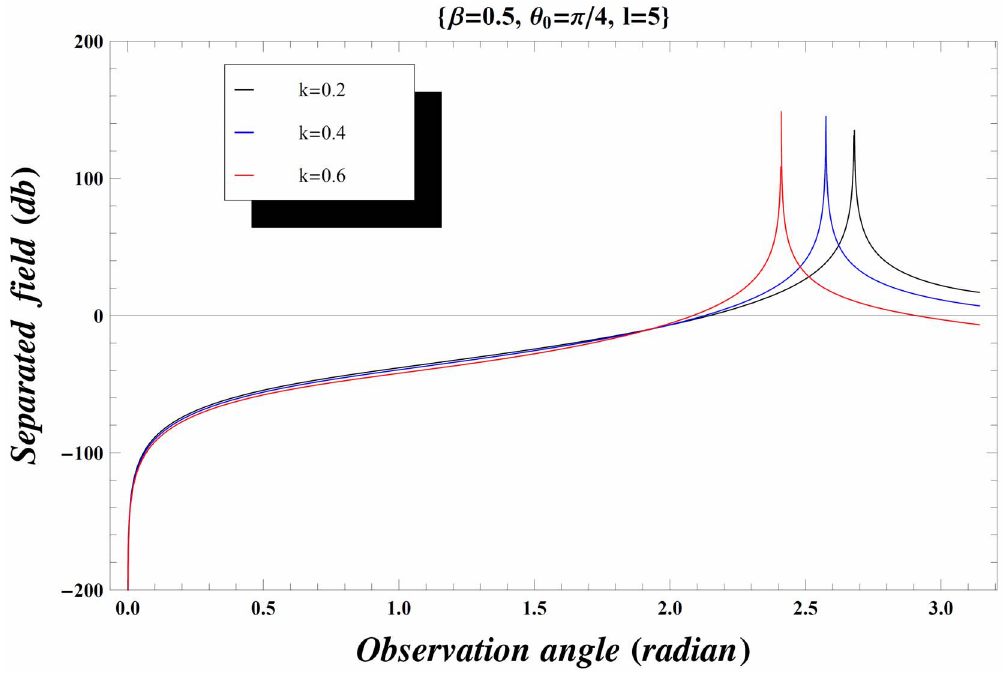
Figure 9. Separated field versus observation angle for different values of wave number k when b 1 ~ 0 : 5 .